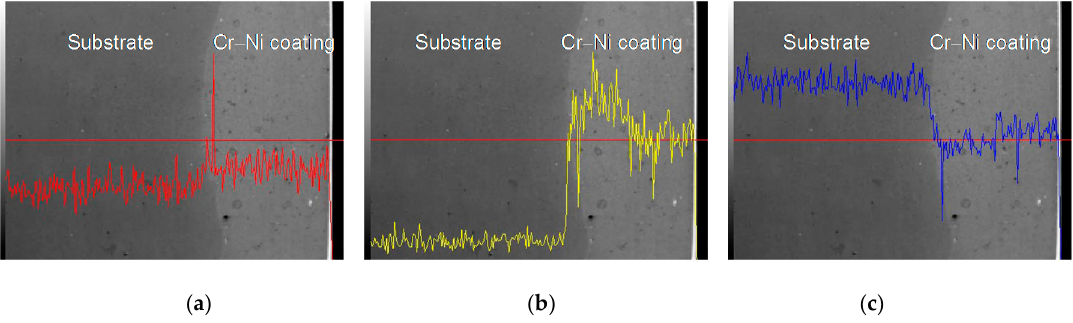
Figure 6. Line scan analysis of 17% Cr–83% Ni coating interface. ( a ) Line scan analysis of Cr content; ( b ) Line scan analysis of Ni content; ( c ) Line scan analysis of Fe content.